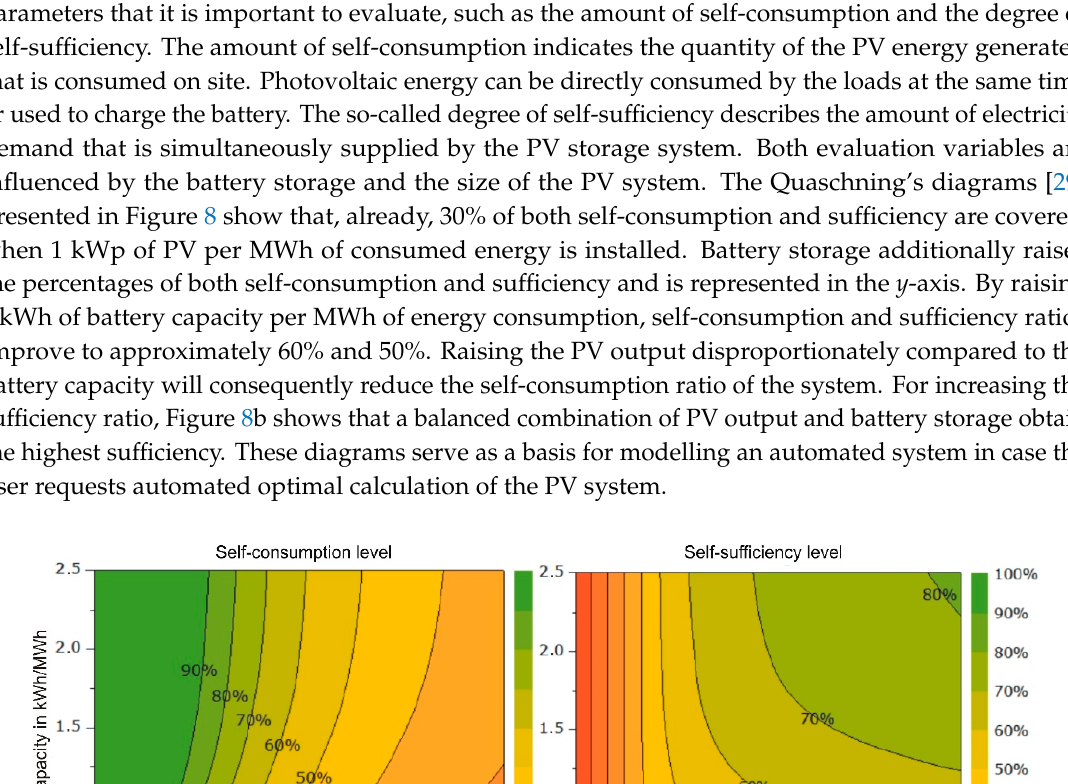
Figure 9. Example of a PV charging carport [30].